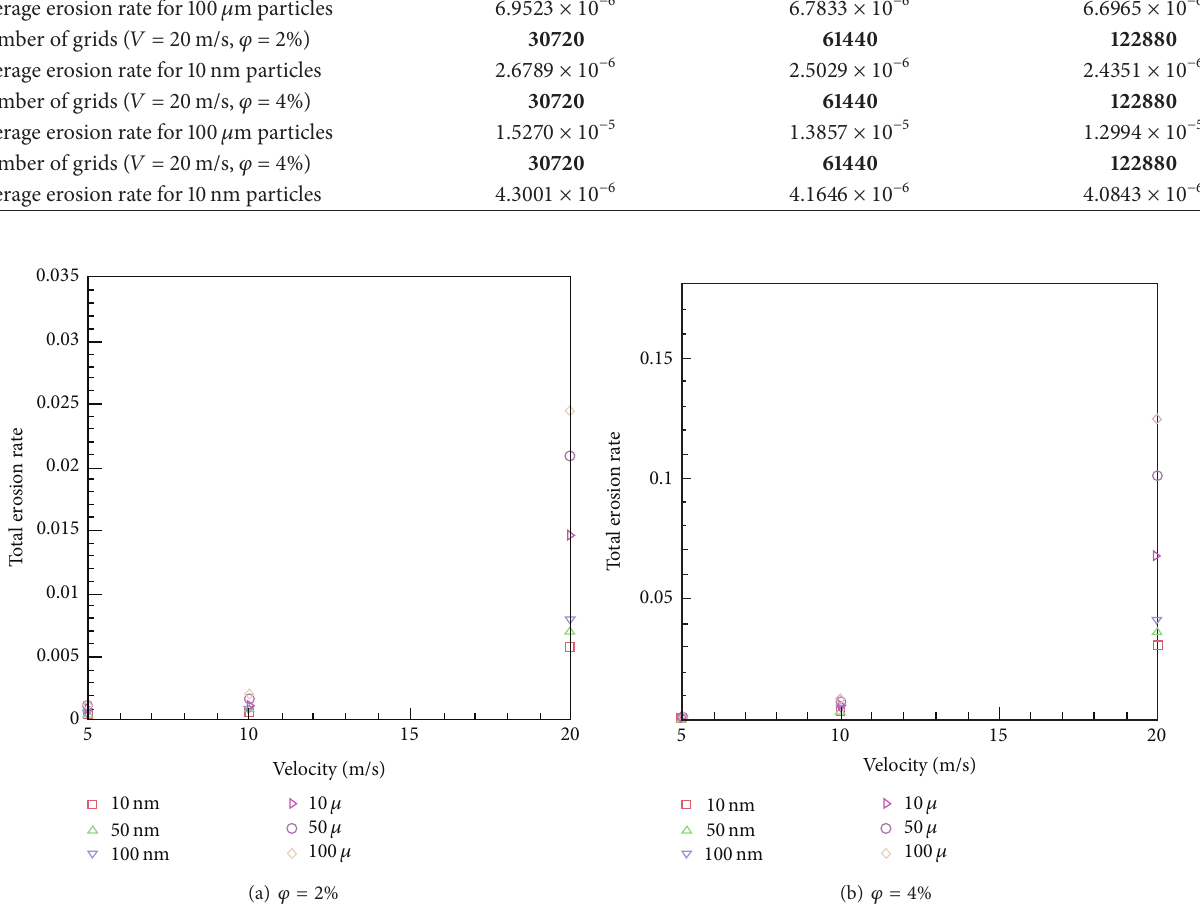
Figure 4: The variation of total erosion rate with